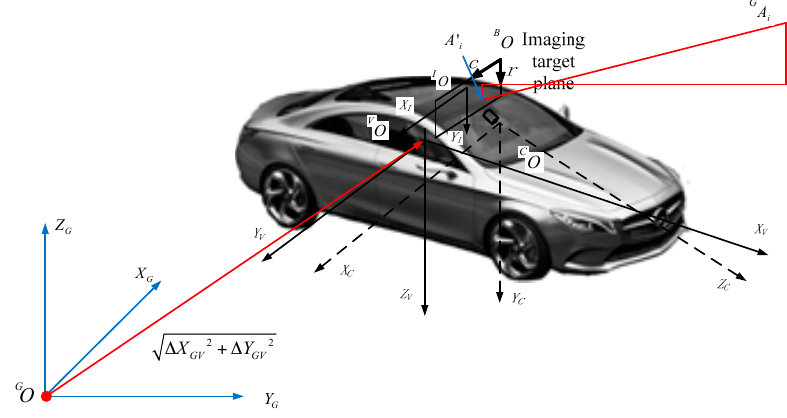
Figure 7. Definition of a coordinate system.